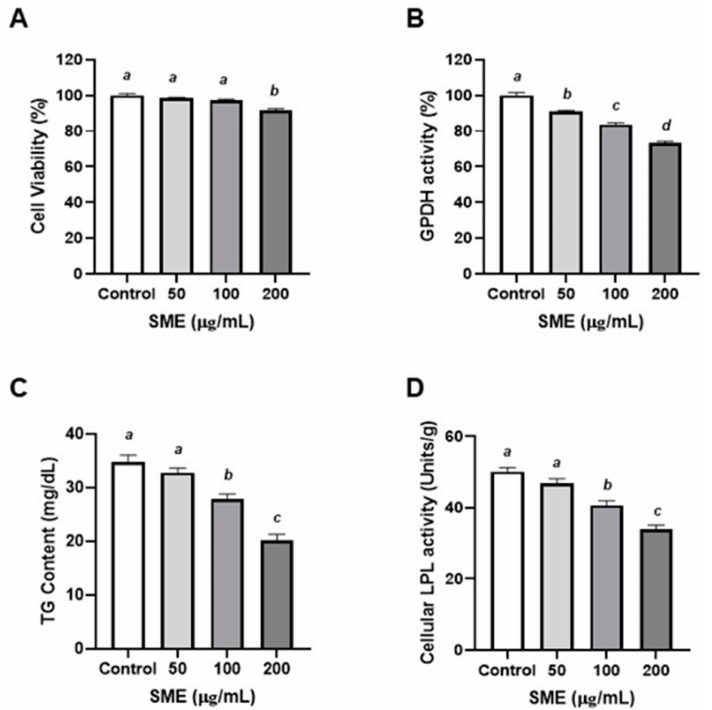
Figure 2. E ff ects of ethanol extract of Spergularia marina (SME) on proliferation and di ff erentiation of porcine pre-adipocytes. Porcine primary adipocytes were treated with SME (50, 100, and 200 µ g / mL) for 48 h. Dimethyl sulfoxide (DMSO) was used as control. ( A ) Cell proliferation was determined by 3-(4,5-dimethylthiazol-2-yl)-2,5-diphenyltetrazolium Bromide (MTT) assay. ( B ) Adipocyte di ff erentiation was accessed by glycerol-3-phosphate dehydrogenase (GPDH) measurement ( C ) Triglyceride (TG) content was determined by manual methods. ( D ) Lipoprotein lipase (LPL) activity was assayed using the Nilsson-Ehle and Schotz methods. Values are means ± SDs, n = 3. Data were analyzed by one-way ANOVA using Kruskal–Wallis analysis followed by Tukey’s post hoc test. Means labeled without a common letter di ff er, p <